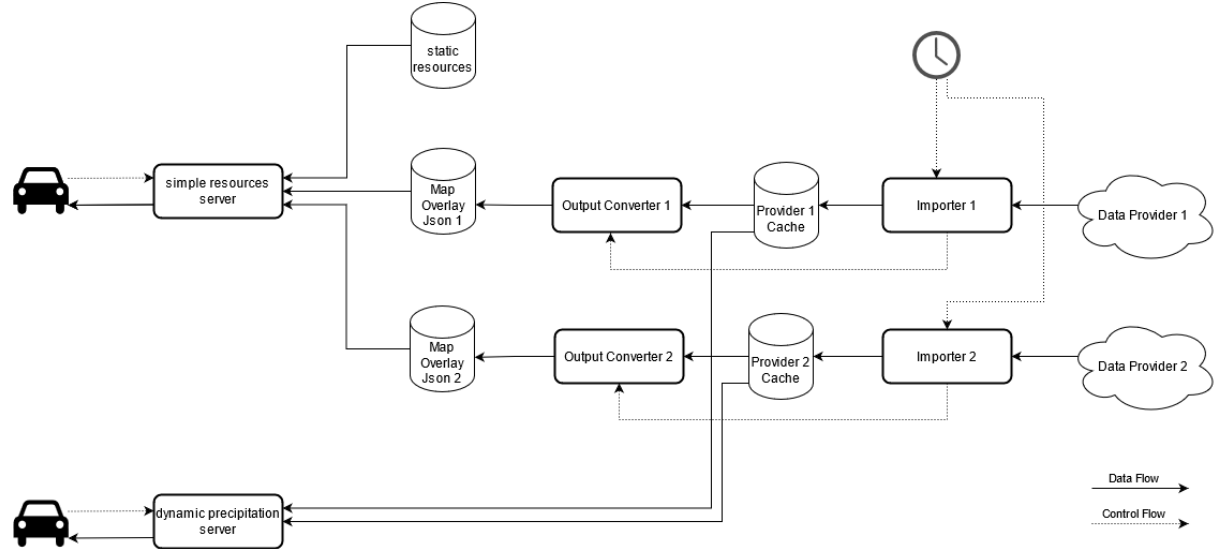
Figure 7. Microservice architecture of the rain map feature